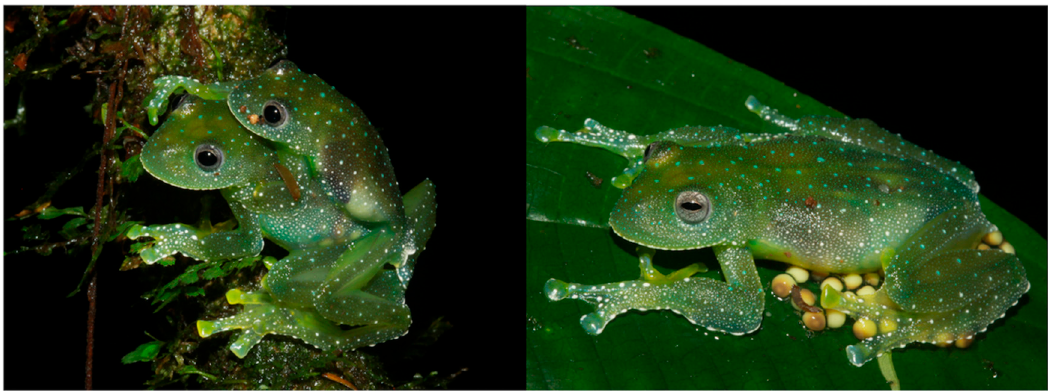
Figure 77. Cochranella resplendens in life. ( Left ): Amplectant pair. ( Right ): Female brooding clutch. Locality: 2 km N from HW 20 on a dirt road out of Guagua Sumaco, Napo province, Ecuador. Photos by Jesse Delia.